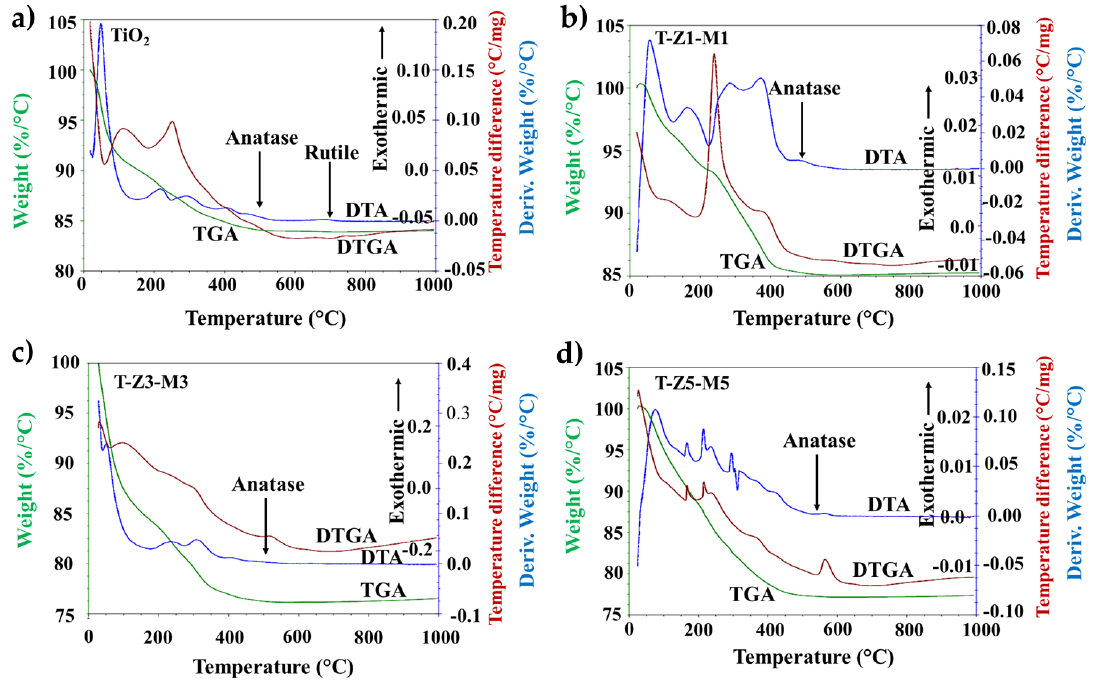
Figure 2. Thermal gravimetric analysis (TGA / DTGA) and di ff erential thermal analysis (DTA) results of ( a ) TiO 2 , ( b ) TiO 2 -ZnO (1%)-MgO (1%), ( c ) TiO 2 -ZnO (3%)-MgO (3%), and ( d ) TiO 2 -ZnO (5%)-MgO (5%) mixed oxide